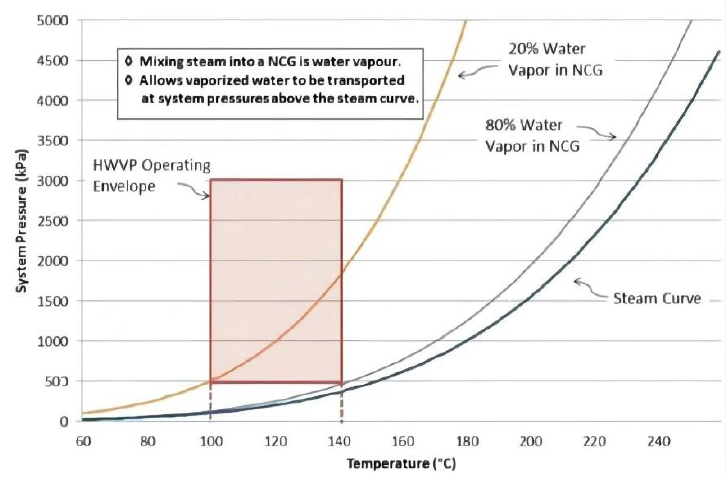
Figure 1. Comparison of hot water vapor and steam [18].